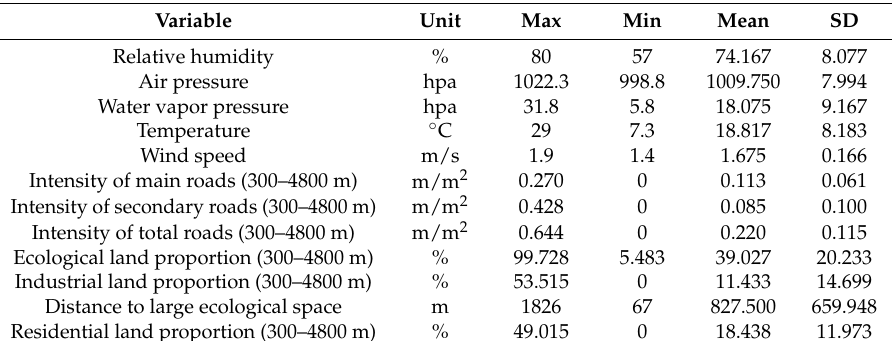
Table 2. The description of independent